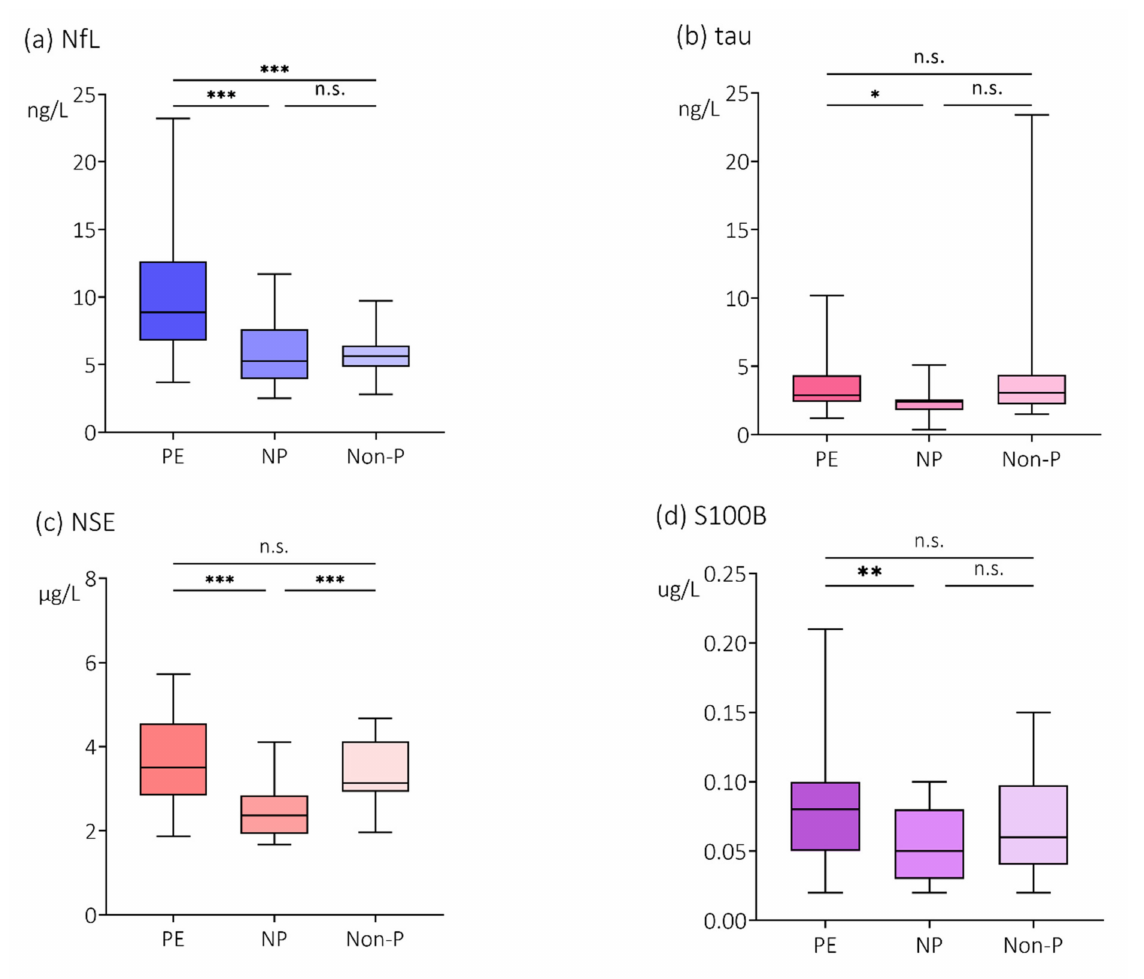
Figure 1. Plasma concentrations of ( a ) NfL, ( b ) tau, ( c ) NSE and ( d ) S100B. Plasma concentrations of the cerebral biomarkers ( a ) neurofilament light (NfL), ( b ) tau, ( c ) neuron specific enolase (NSE) and ( d ) S100B in women with preeclampsia (PE), women with normal pregnancies (NP) and non- pregnant women (Non-P). Values are represented by medians with interquartile range (IQR). Pairwise comparisons by Mann-Whitney U-test, Bonferroni correction. * p < 0.05; ** p < 0.01; *** p < 0.001; n.s. =